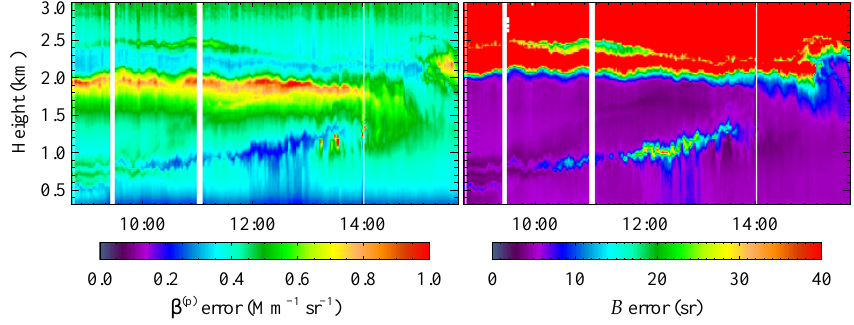
Fig. 18. Retrieved errors for plots (c–d) of Fig. 17.